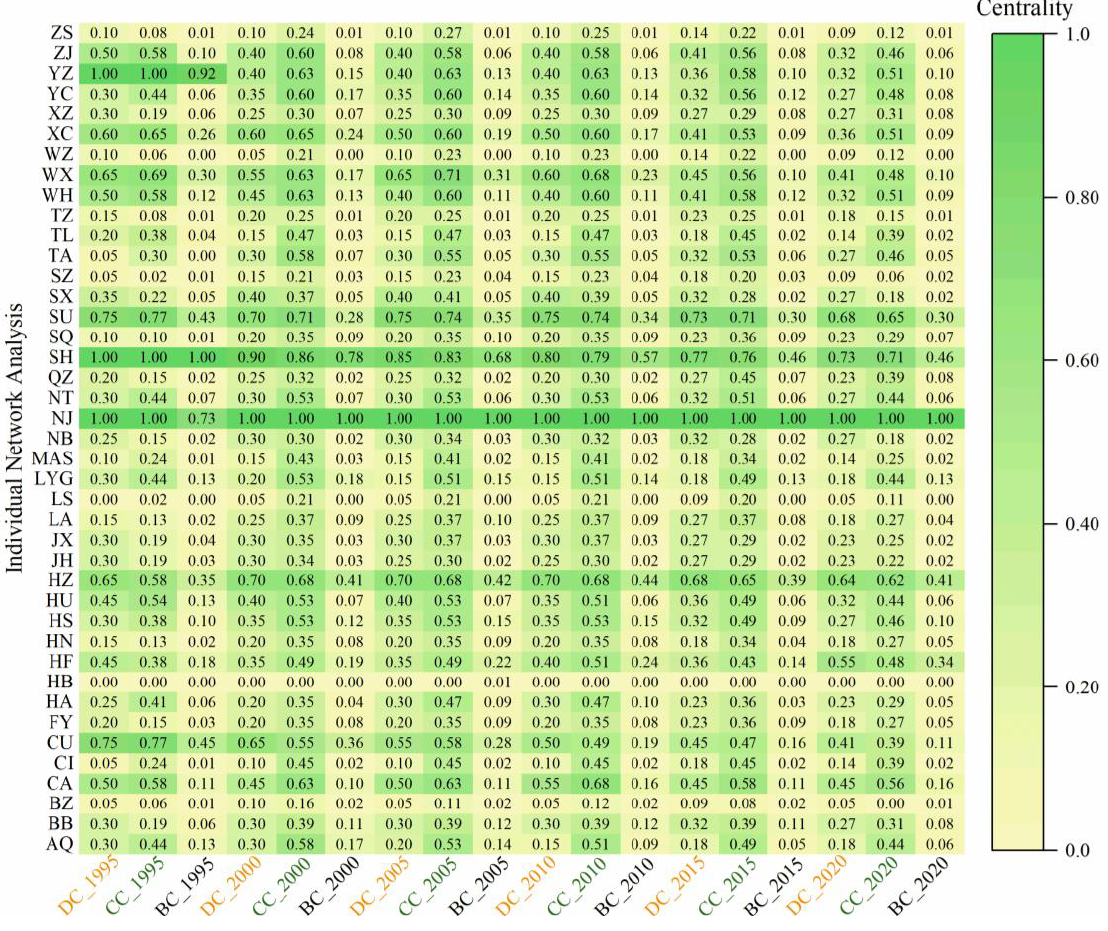
Figure 5. The individual network characteristics of land pressure in the YRDR. DC_1995, CC_1995 and BC_1995 represent the degree, closeness and betweenness centrality in 1995.